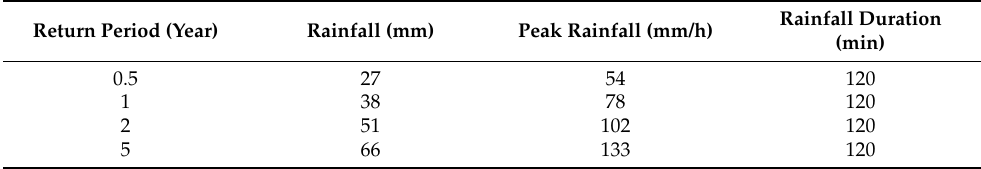
Table 5. Rainfall data under different design rainfall return